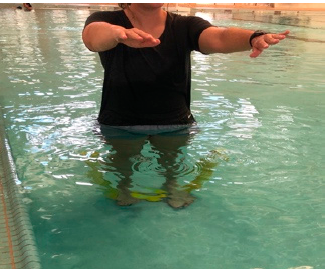
Figure 2. ( a ) Level 3 Exercise: Standing in unilateral stance while the opposite leg flexes and extends the knee with “noodle” under the foot. ( b ) Level 4 Exercise: Cutting in different directions (e.g., anteriorly/posteriorly and medial/lateral), at differing speeds and in deeper water.